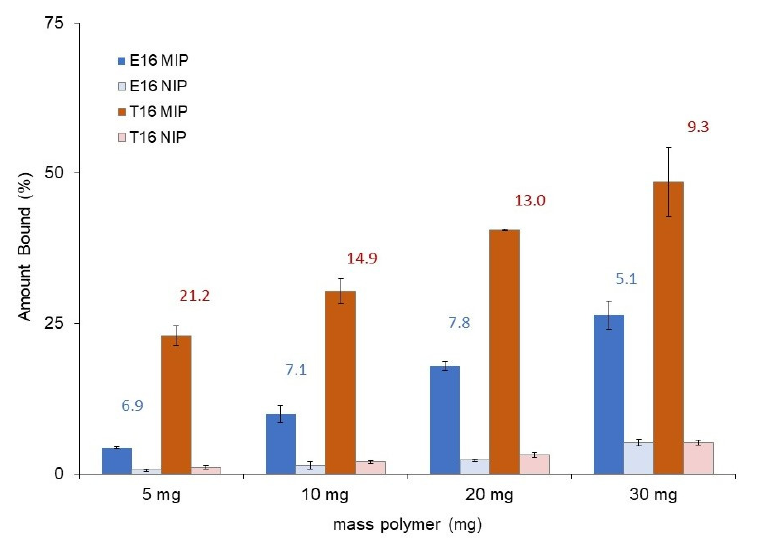
Figure 6. Rebinding results for E 16 MIPCHCl3 and T 16 MIPCHCl3 in CHCl 3 , using 1 mL 0.8 mM solution of 1 with a binding time of 30 min. All experiments were performed in triplicate. Numerical values above the bars indicate imprinting factor (IF) values.